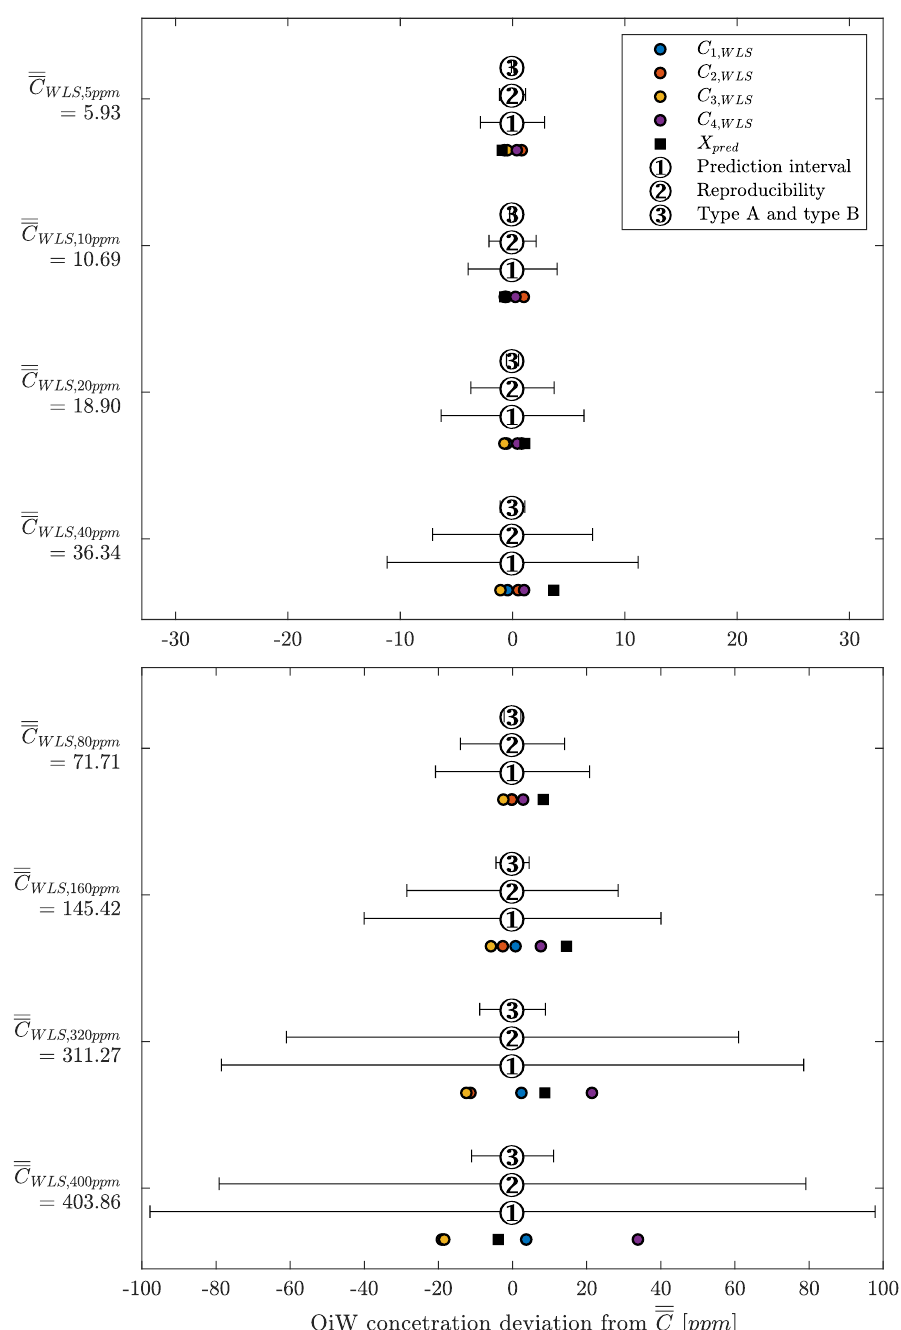
Figure 18. The analysis of three different methods for determining the best estimation of the OiW monitors’ uncertainty based on WLS in the entire range of interest. The grand mean for each concentration is used as a reference point and categorized on the y-axes. The plot is divided into two subplots for better scaling of the OiW concentration range of